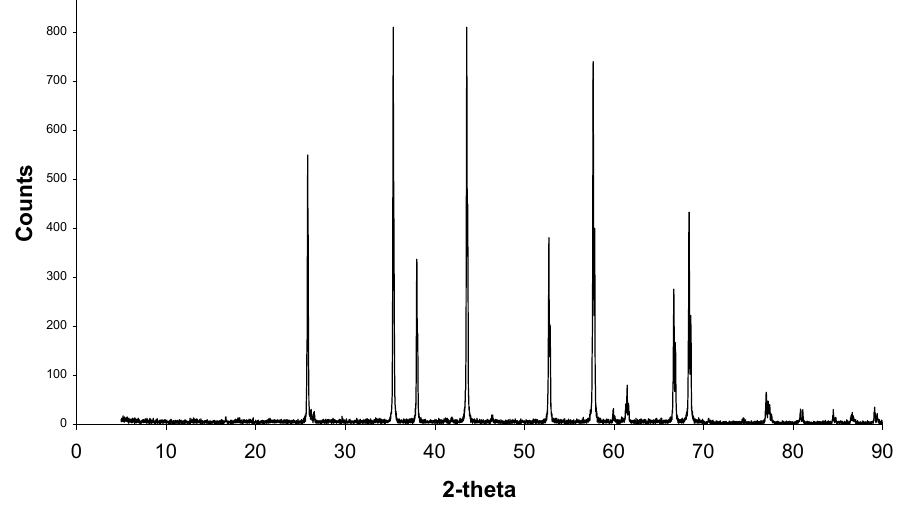
Figure 2. XRD pattern for alumina showing corundum peaks signalling that the alumina is a pure